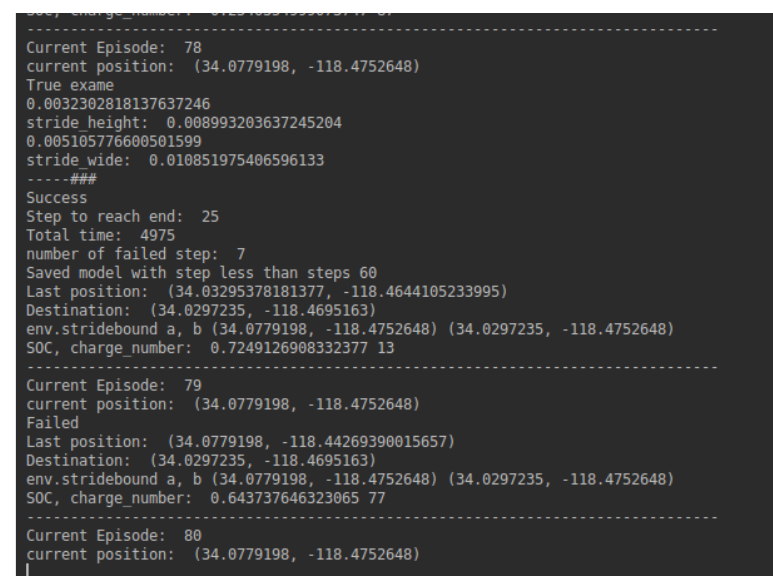
Figure 7. Benchmarking of the energy requirement for the second route for SARSA vs. DDQN and Google Maps.